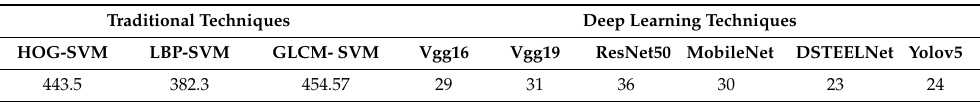
Table 7. Comparison of Computational time (ms) for traditional and deep learning techniques on GNEU dataset.